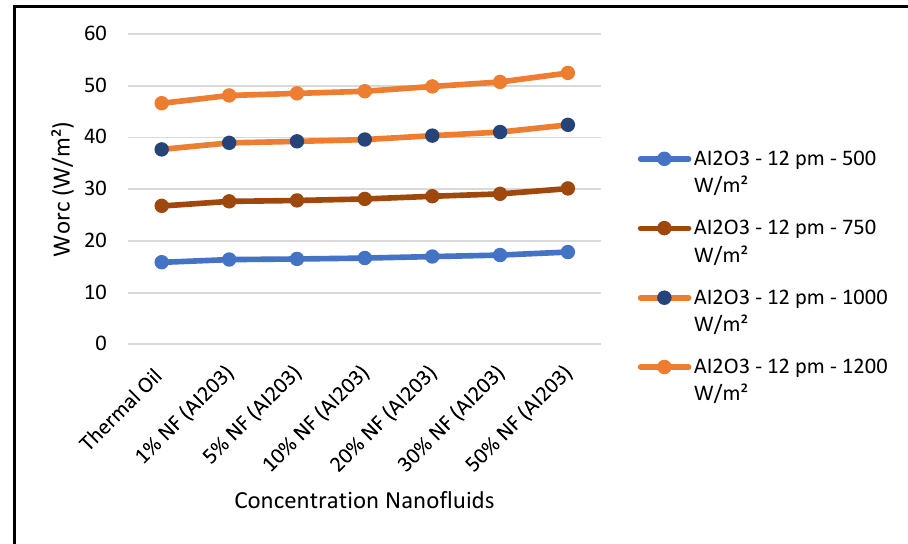
Figure 23. ORC work produced at different concentrations of Al 2 O 3 and solar radiations.